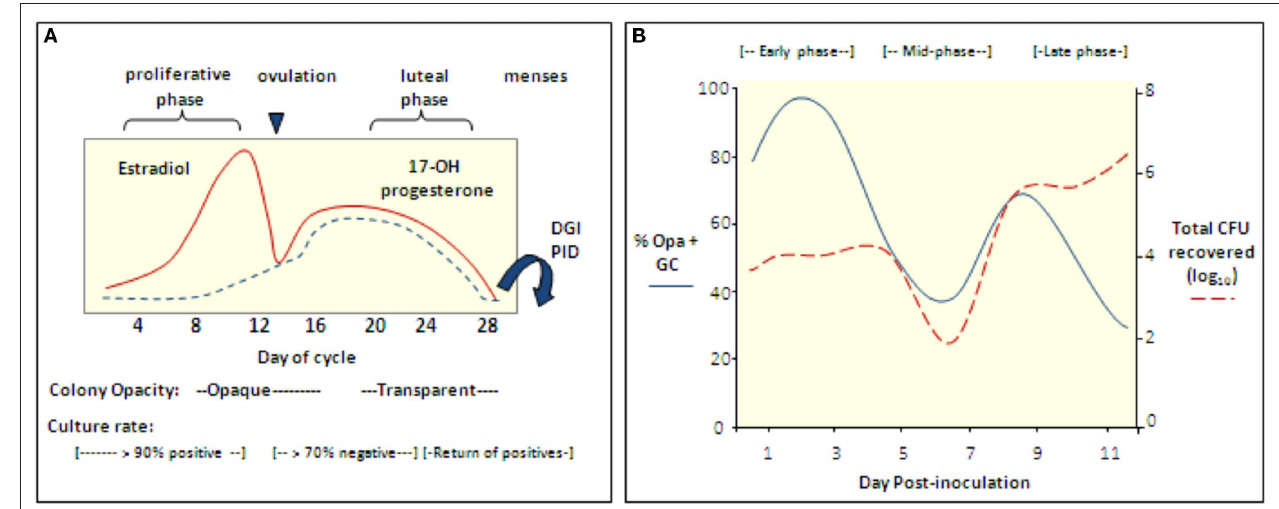
Figure 3 | The reproductive cycle influences gc infection of women and mice. (A) Culture rates from women with gonorrhea and the opacity phenotype of cervical isolates from infected women with respect to stages of the menstrual cycle (Koch, 1947; Johnson et al., 1969; James and Swanson, 1978; McCormack and Reynolds, 1982). In one study, women with gonorrhea were hospitalized without treatment and in four of four women, positive cultures were followed by five to six consecutive negative cultures during the secretory phase; cultures became positive again at menses (Koch, 1947). Gonococcal PID and disseminated gonococcal infection most frequently occur at or shortly after menses (Holmes et al., 1971) and Gc from fallopian tubes from women with salpingitis were reported to be Opa − (Draper et al., 1980). (B) Cartoon depicting